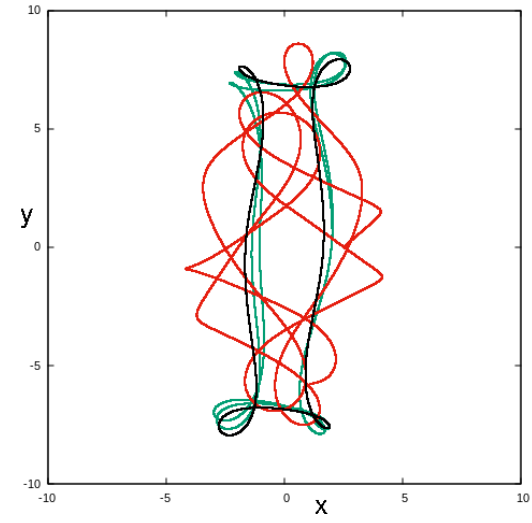
Figure 6. The f PO for E J = − 118,092 (in black) together with two sticky periodic orbits (red and green) at the same energy, integrated for about three periods of f. The orbits do not reach the unstable ) = ( ± 1.21, ± 9.65 ) Lagrangian points, located at ( x L , y L 1,2 1,2